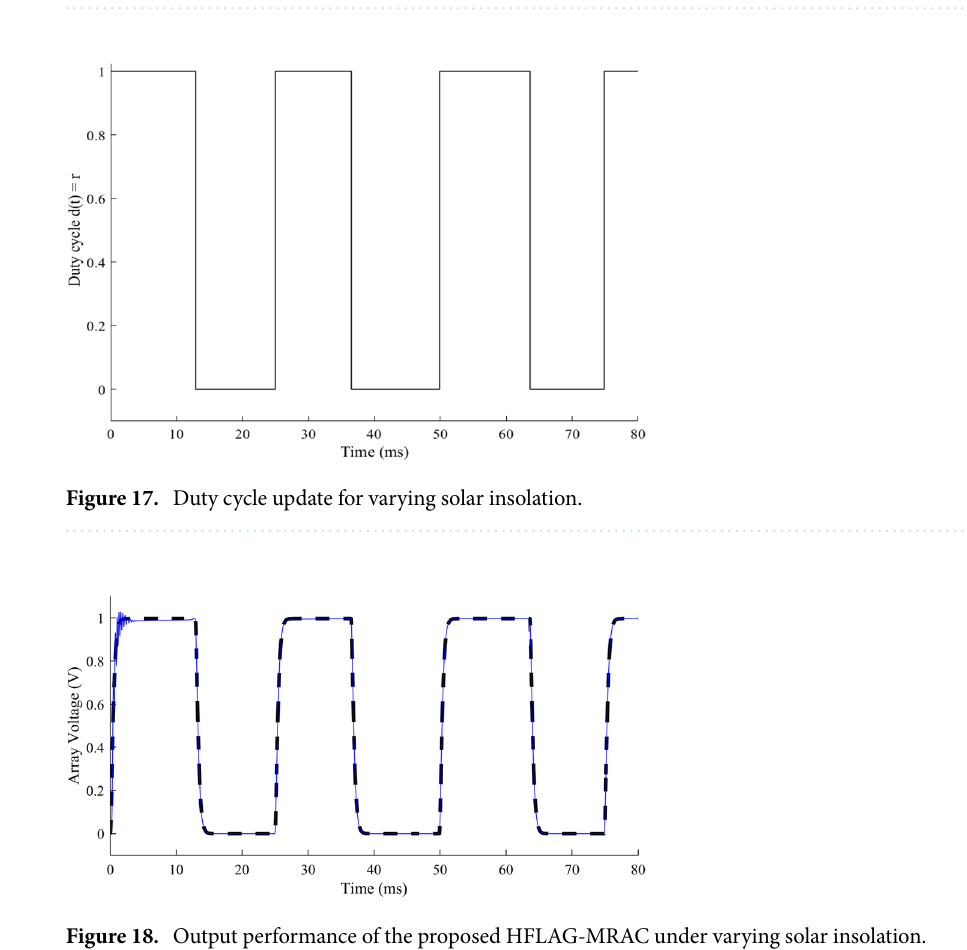
Figure 16. Step input irradiance representing varying solar insolation.